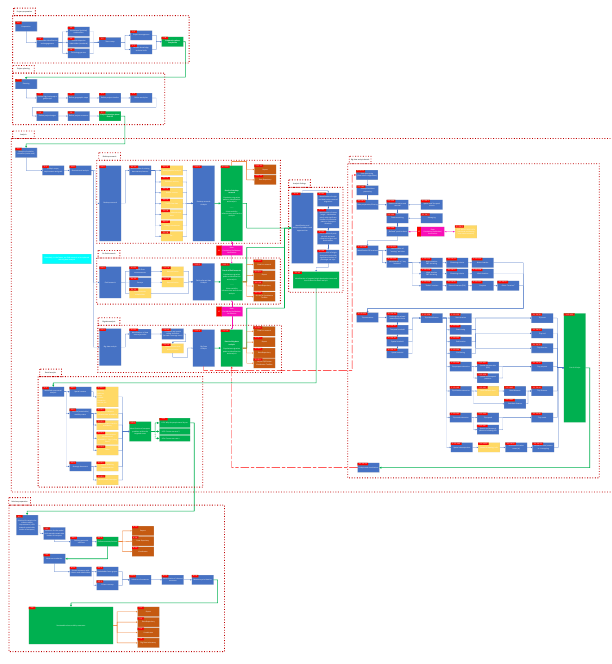
Figure 2. Illustration of steps within the